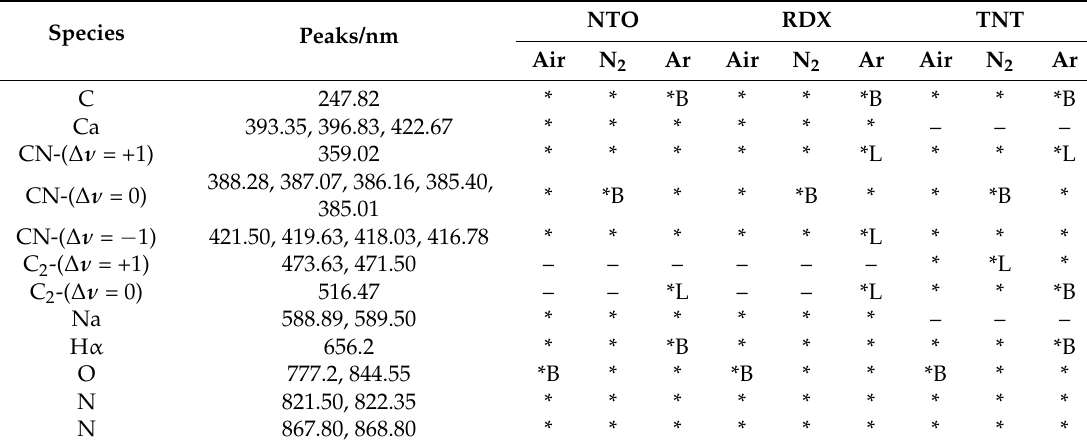
Table 3. Description of elemental and molecular peaks obtained in three atmospheres for NTO, RDX, and TNT